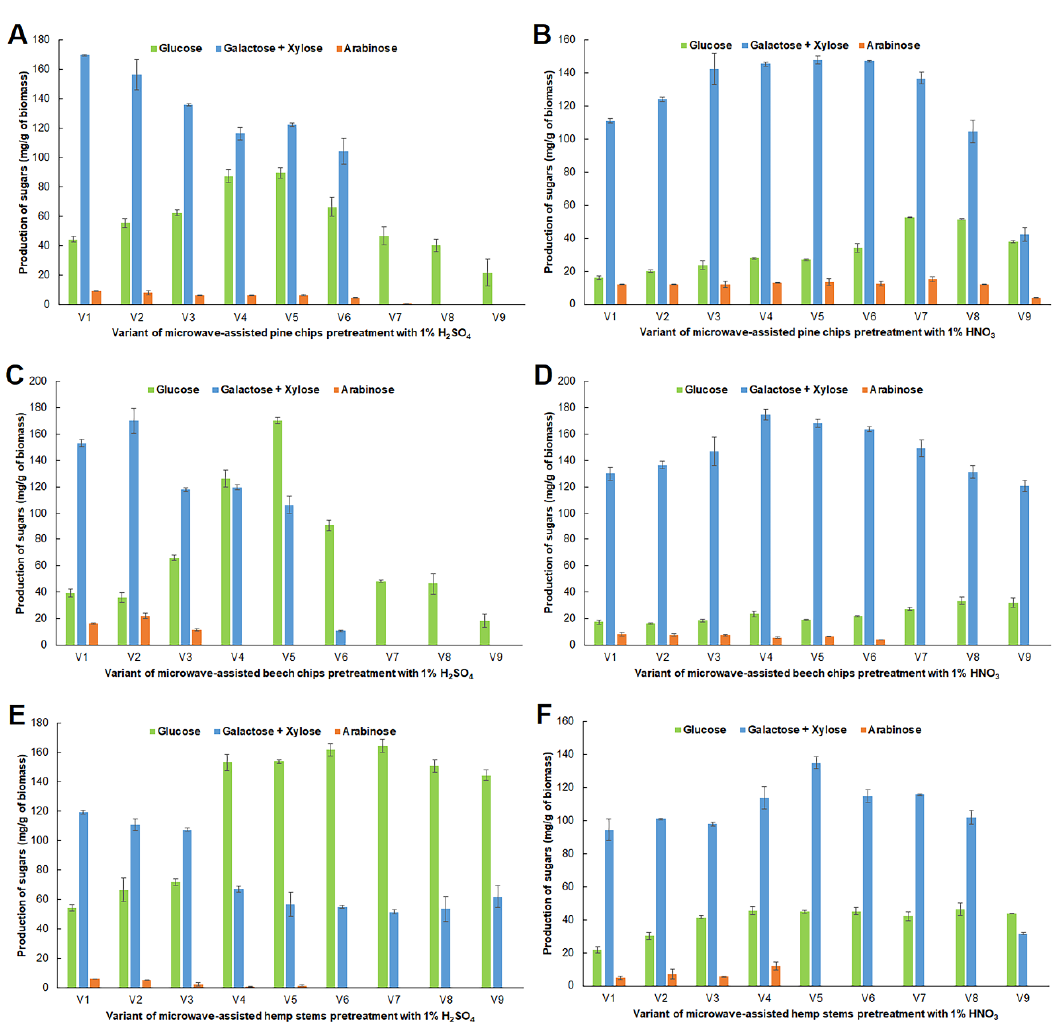
Figure 1. Concentrations of glucose, galactose / xylose and arabinose after microwave pretreatment in experimental variants (( A )—pine chips, 1% v / v H 2 SO 4 ; ( B )—pine chips, 1% v / v HNO 3 ; ( C )—beech chips, 1% v / v H 2 SO 4 ; ( D )—beech chips, 1% v / v HNO 3 ; ( E )—hemp stems, 1% v / v H 2 SO 4 ; ( F )—hemp stems, 1% v / v HNO 3 ).